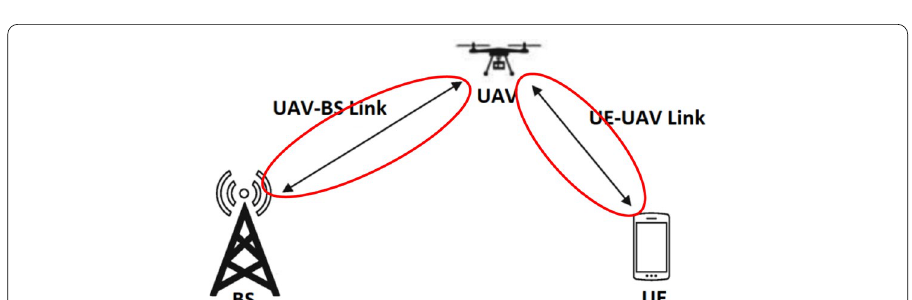
Fig. 2 Explicit energy usage for